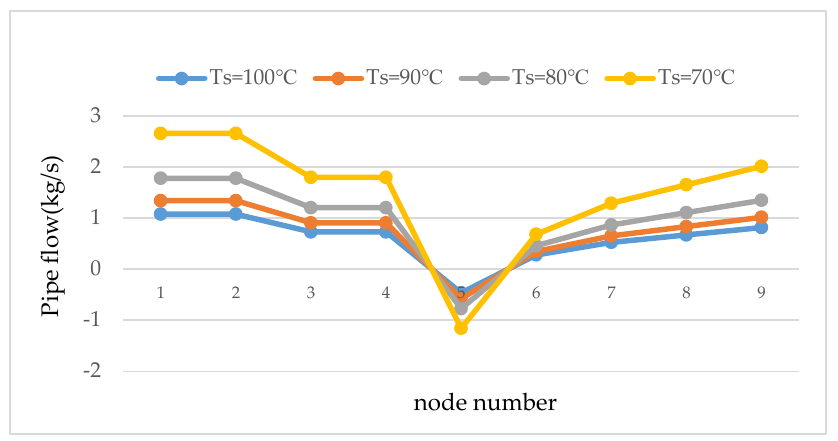
Figure 8. Pipeline flux under different source-node supply water temperatures.